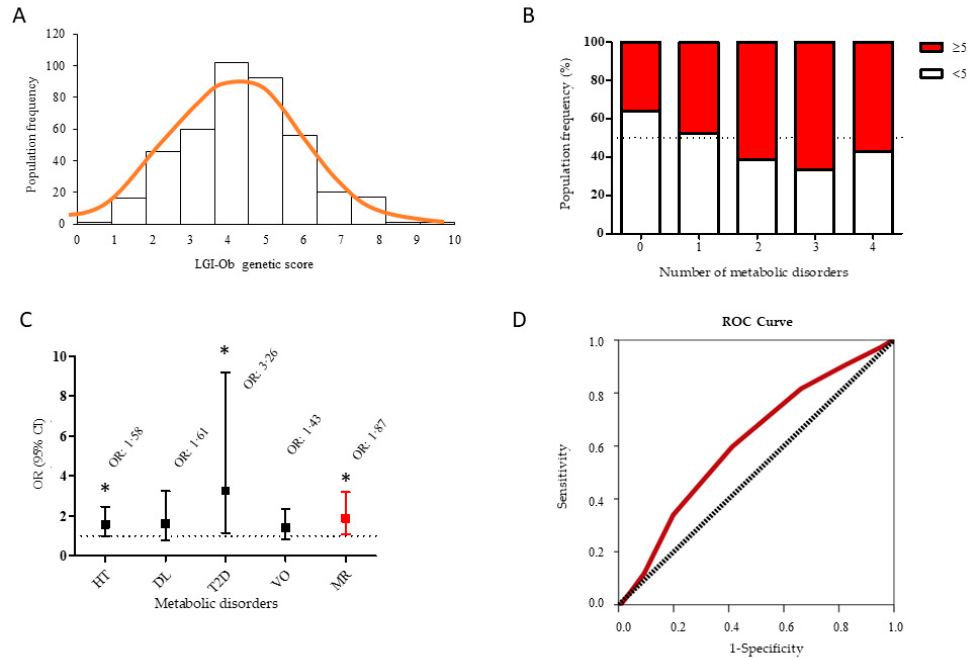
Figure 4. ( A ) Distribution of the frequency of LGI-Ob genetic score computed in the general adult population studied ( n = 376); ( B ) Prevalence of the number of metabolic disorders suffered by the population analysed and categorised according to low (<5, n = 201) or high ( ≥ 5; n = 175) LGI-Ob genetic score; ( C ) Odds ratio (OR) for the metabolic disorders: Hypertension (HT), dyslipidemia (DL), type 2 diabetes (T2D), visceral obesity (VO), and metabolic risk (MR) of individuals with high LGI-Ob score ( ≥ 5) in comparison with individuals with low LGI-Ob score (<5). OR was estimated by binary logistic regression taking as a reference (OR = 1, indicated by the dashed line) individuals with low LGI-Ob score and adjusting for age, sex, and ethnicity. ( D ) Receiver operating characteristics (ROC) curve analysis showing the performance of LGI-Ob genetic score to classify potential individuals for obesity-associated metabolic disturbances. * p <